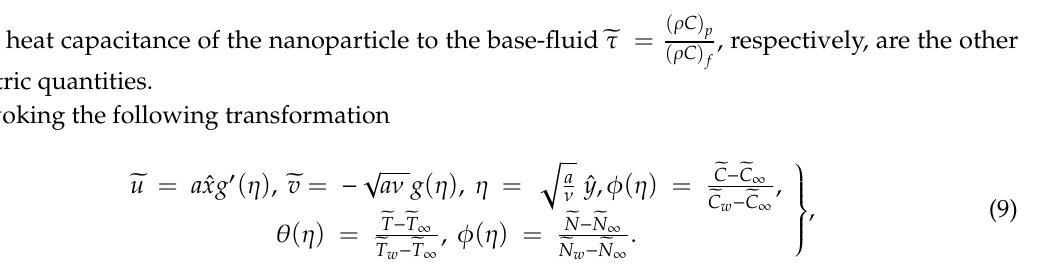
( ρ C ) p , respectively, are the other ( ρ C ) f